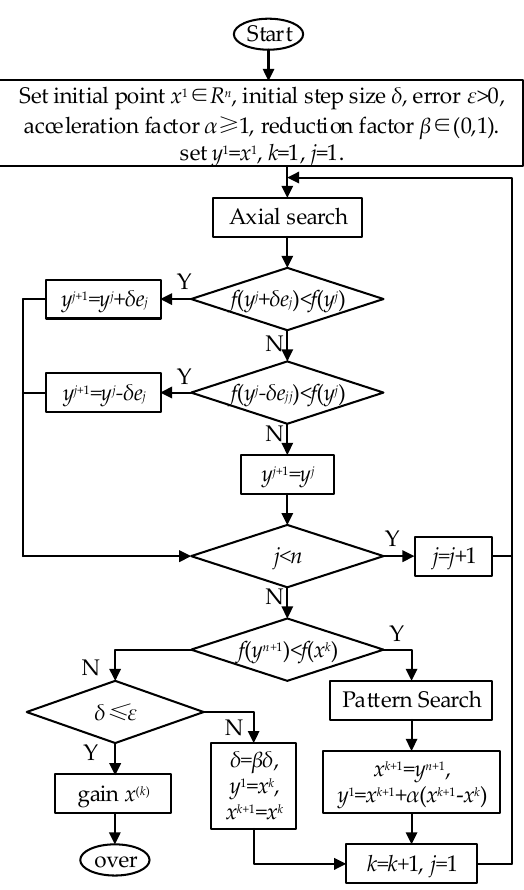
Figure 5. Pattern search optimization algorithm.